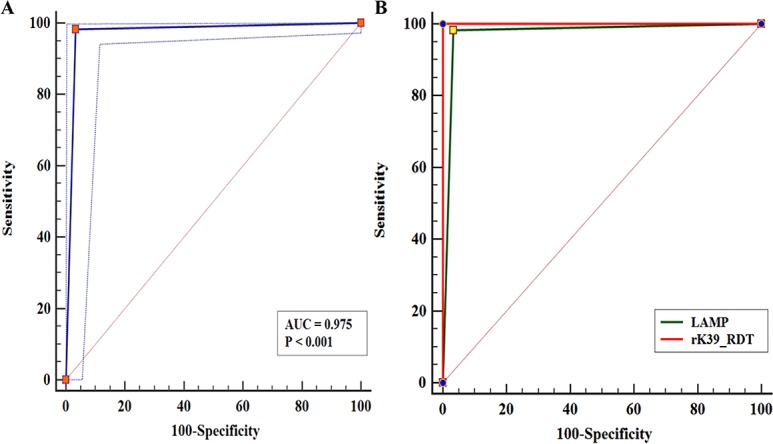
Receiver operating curve (ROC) curve analysis for assessing the diagnostic accuracy of LAMP assay.(A) ROC curve for LAMP assay for diagnosis of VL at validation sites. The AUCROC for LAMP assay was 0.975; p <0.0001 depicting it to be an excellent diagnostic test (B)-ROC curve analysis showing comparison of rK39 RDT and LAMP. The AUCROCs for rK39 RDT and LAMP were 1.00 and 0.975 respectively. No remarkable difference between two AUCROCs 0.0254 (SE, 0.0125, p -0.1053).